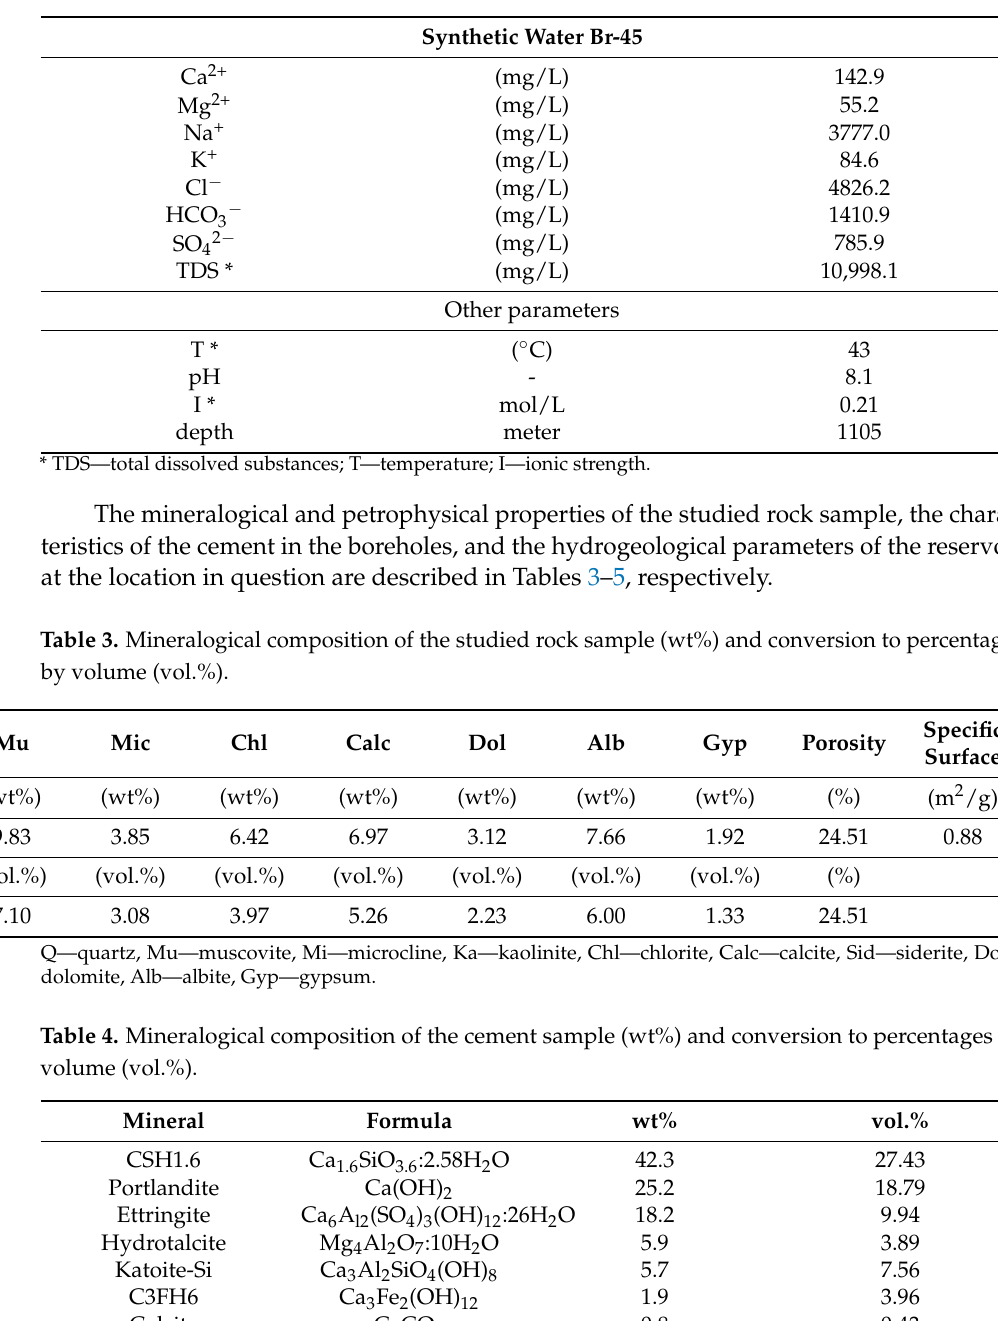
Table 2. Physico-chemical parameters of synthetic brackish water Br-45.